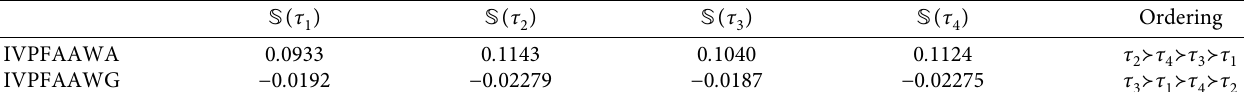
Table 2: Ranking and ordering of alternatives.